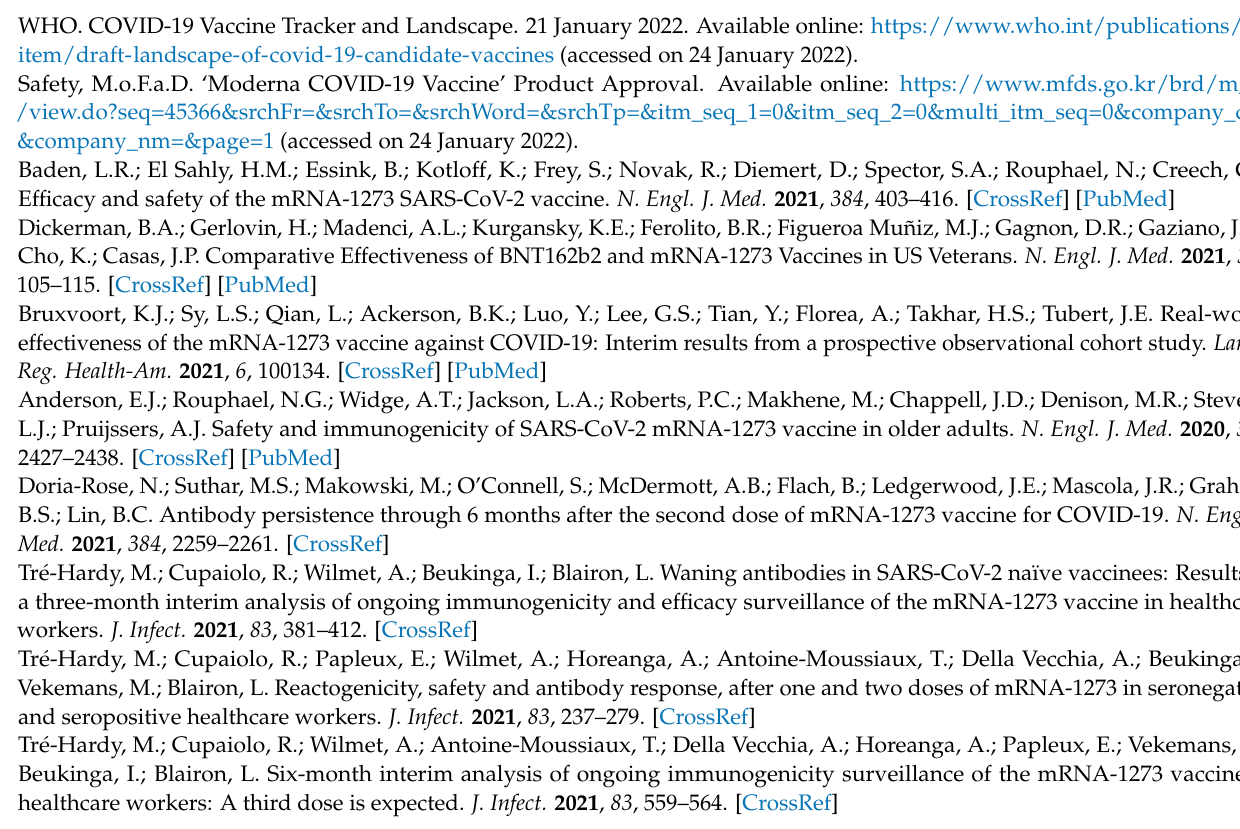
systemic adverse events at each time point. Immune responses are presented as geometric mean titer; Figure S4: relationship of anti-SARS-CoV-2 S antibody response with (A) systemic SUM and SOM, and (B) localized SUM and SOM at each time point; Figure S5: relationship of neutralizing antibody response (PRNT ND 50 ) with (A) systemic SUM and SOM, and (B) localized SUM and SOM at each time point. PRNT: plaque reduction neutralization